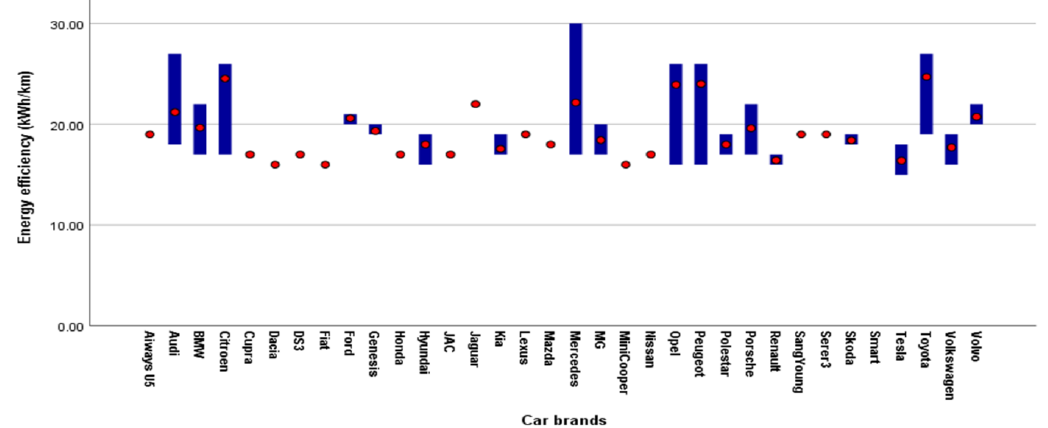
Figure 12. Range bar variation (min, max, mean) representation of energy efficiency vs. brands of cars.